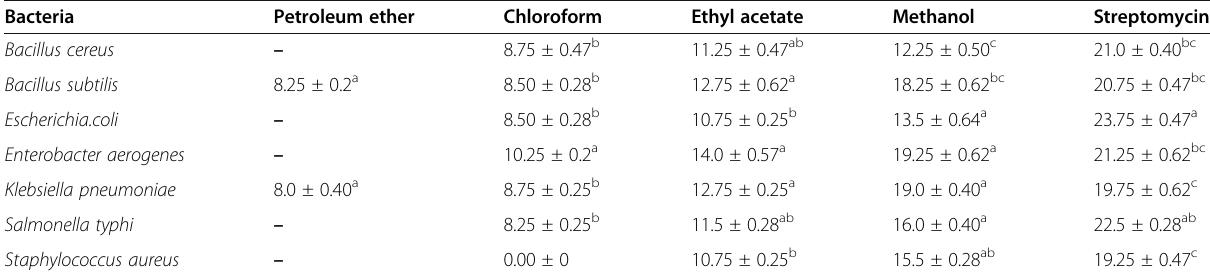
Table 2 Antibacterial activity of different extracts of E. cotinifolia against some human pathogenic bacteria (in mm)